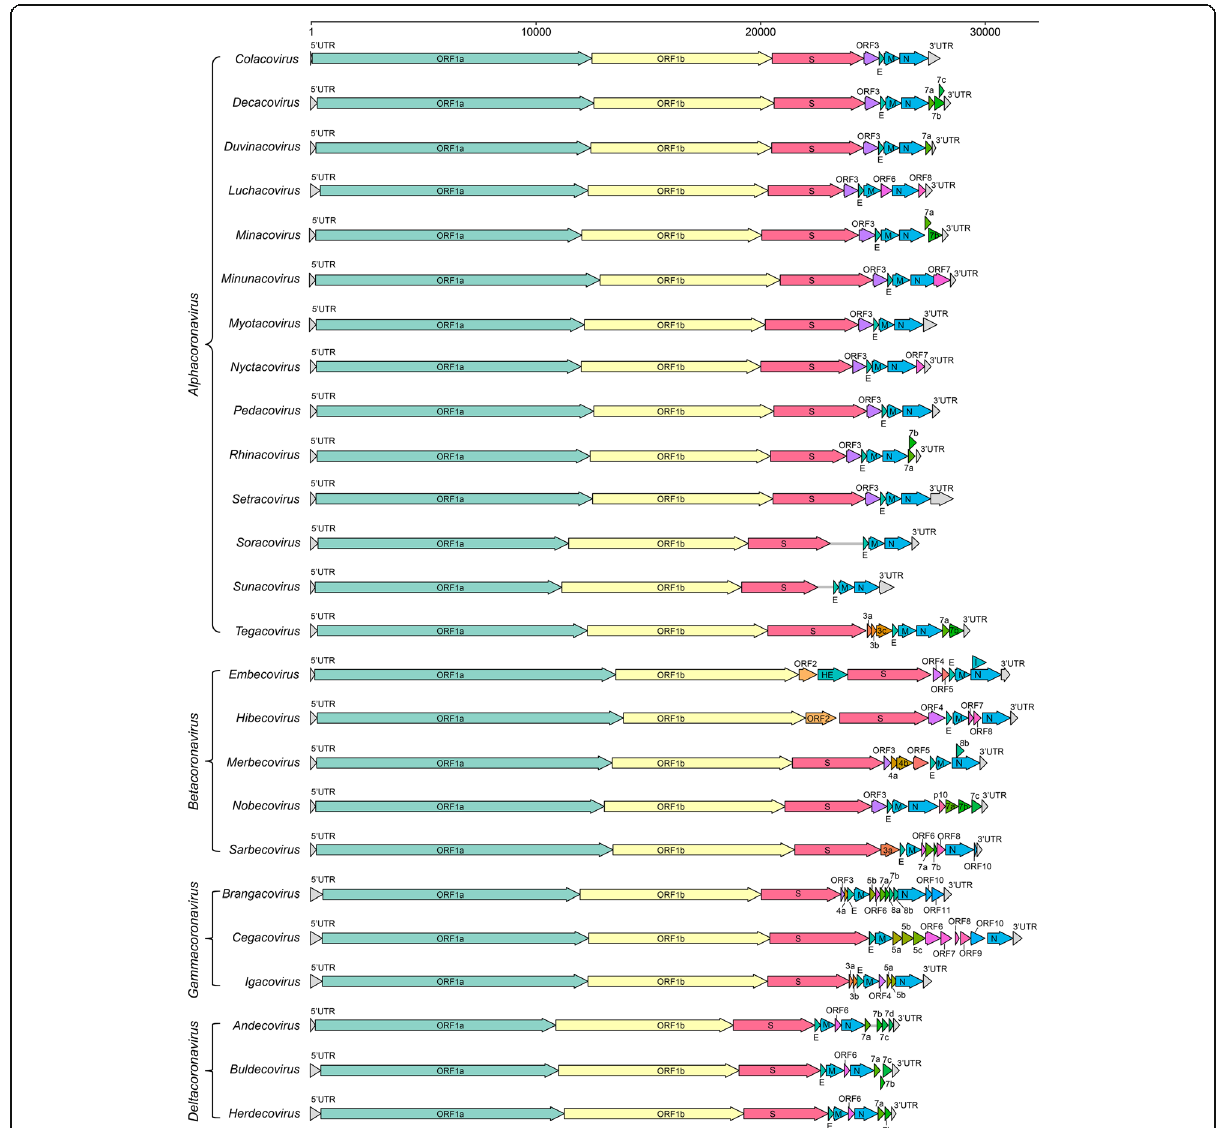
Fig. 5 Gene composition of 25 subgenera in 4 viral genera of Orthocoronavirinae . The reference strains used for mapping in each subgenus are as follows: Colacovirus (Bat-CoV CDPHE15/USA/2006, NC_022103.1), Decacovirus (Bat-CoV HKU10, NC_018871.1), Duvinacovirus (229E-related bat- CoV BtKY229E-1, KY073747.1), Luchacovirus (AcCoV-JC34, NC_034972.1), Minacovirus (FRCoV-NL-2010, NC_030292.1), Minunacovirus (Bat-CoV HKU8, NC_010438.1), Myotacovirus (BtMr-CoV/SAX2011, NC_028811.1), Nyctacovirus (Bat-CoV HKU33, MK720944.1), Pedacovirus (PEDV, NC_003436.1), Rhinacovirus (SADS-CoV, MT199592.1), Setracovirus (NL63-related bat-CoV BtKYNL63-9b, NC_048216.1), Soracovirus (Shrew-CoV/Tibet2014, KY370053.1), Sunacovirus (Wencheng Sm shrew CoV Xingguo-74, KY967715.1), Tegacovirus (CCoV/NTU336/F/2008, GQ477367.1), Embecovirus (Murine CoV, JX169867.1), Hibecovirus (Bat Hp-betacoronavirus/Zhejiang2013, NC_025217.1), Merbecovirus (Human MERS-CoV, NC_019843.3), Nobecovirus (Rousettus bat-CoV GCCDC1 356, NC_030886.1), Sarbecovirus (SARS-CoV-2, NC_045512.2), Brangacovirus (Canada goose CoV Cambridge_Bay_2017, MK359255.1), Cegacovirus (Beluga Whale CoV SW1, NC_010646.1), Igacovirus (Turkey CoV, NC_010800.1), Andecovirus (Wigeon CoV HKU20, NC_016995.1), Buldecovirus (Common-moorhen CoV HKU21, NC_016996.1), Herdecovirus (Night-heron CoV HKU19,